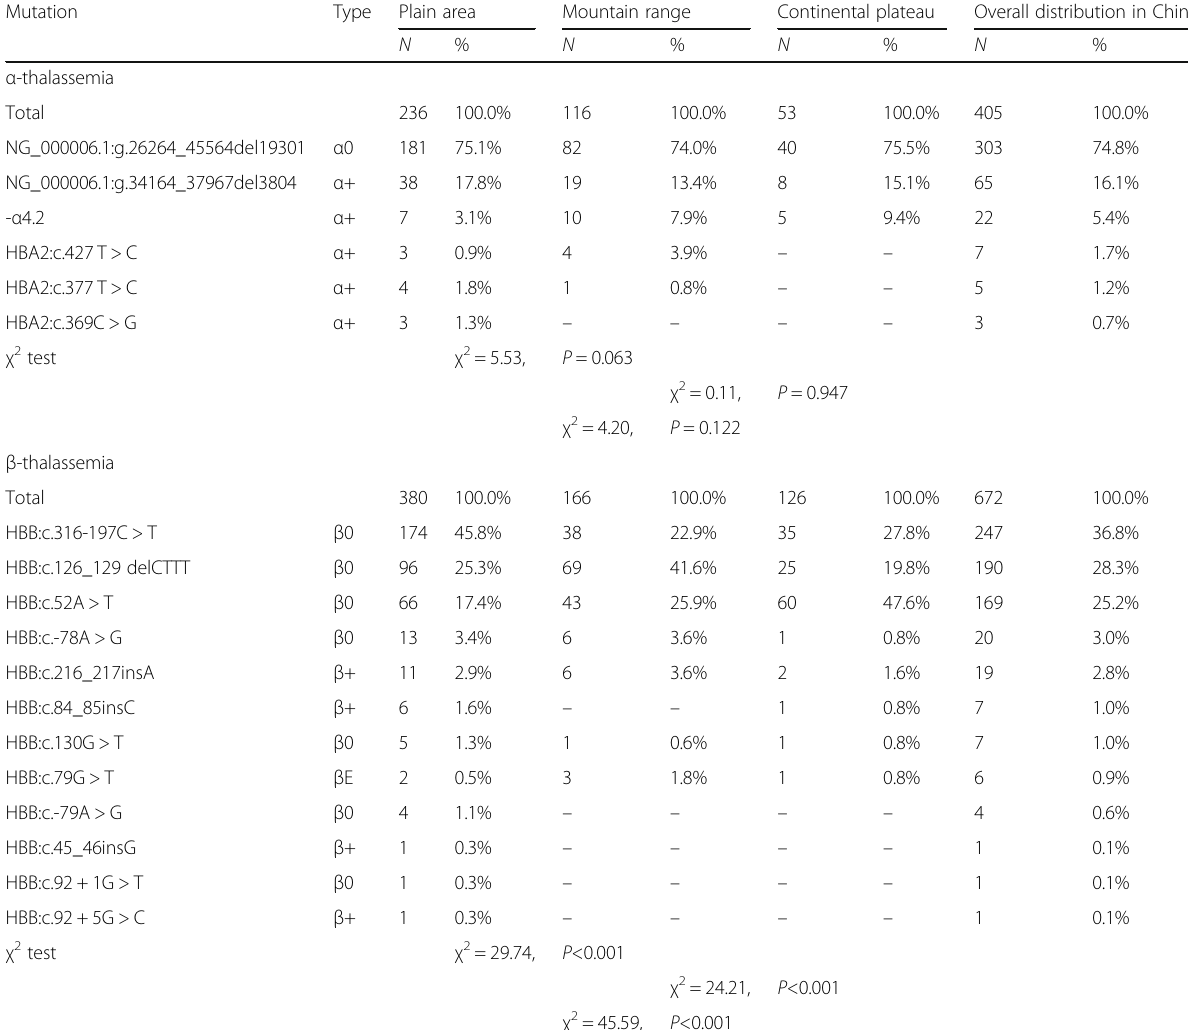
Table 5 Frequency and distribution of α and β thalassemia mutations according to different elevation